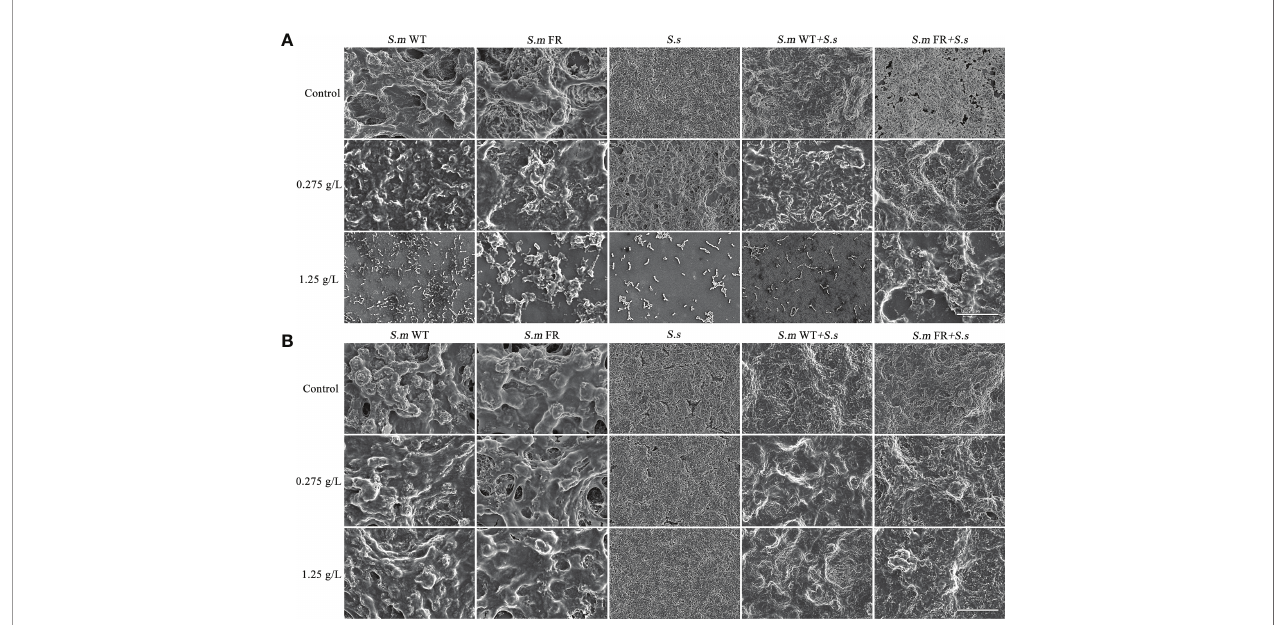
FIGURE 3 | SEM images of the structure of bio fi lm in different NaF concentrations at ×2,000 magni fi cation. (A) Bio fi lm formation. (B) Pre-formed bio fi lms. Size marker equals 20 m